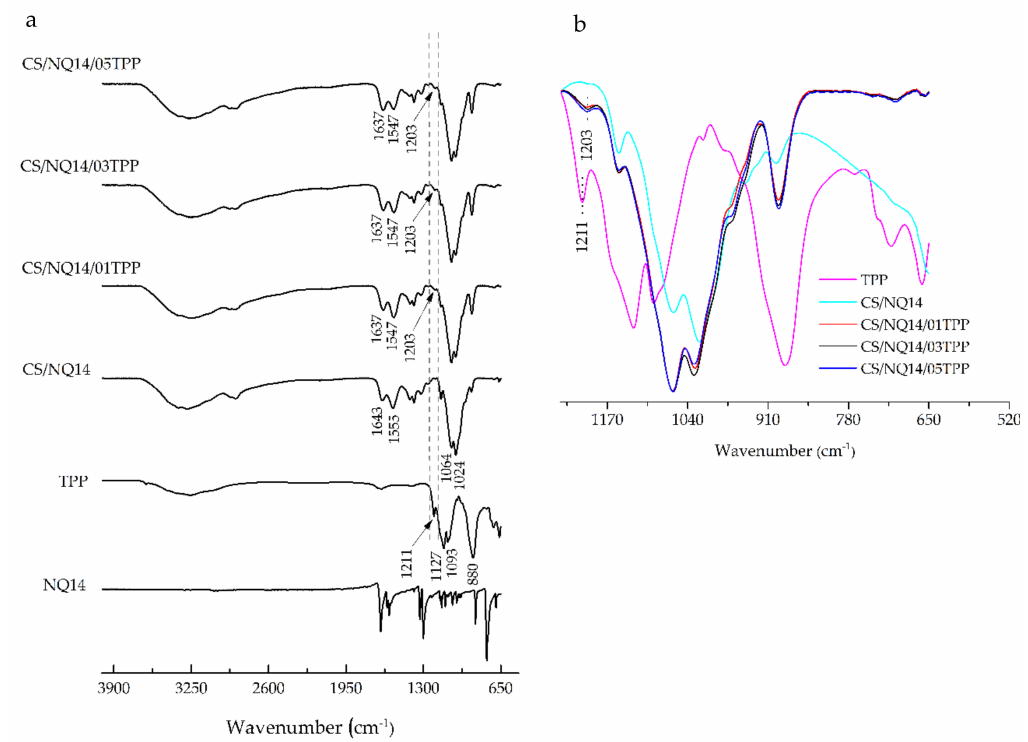
Figure 2. FTIR spectra of NQ14, TPP, non-crosslinked and ionically crosslinked chitosan membranes after NQ14 drug loading ( a ) from 4000–500 cm − 1 and ( b ) from 1245–520 cm − 1